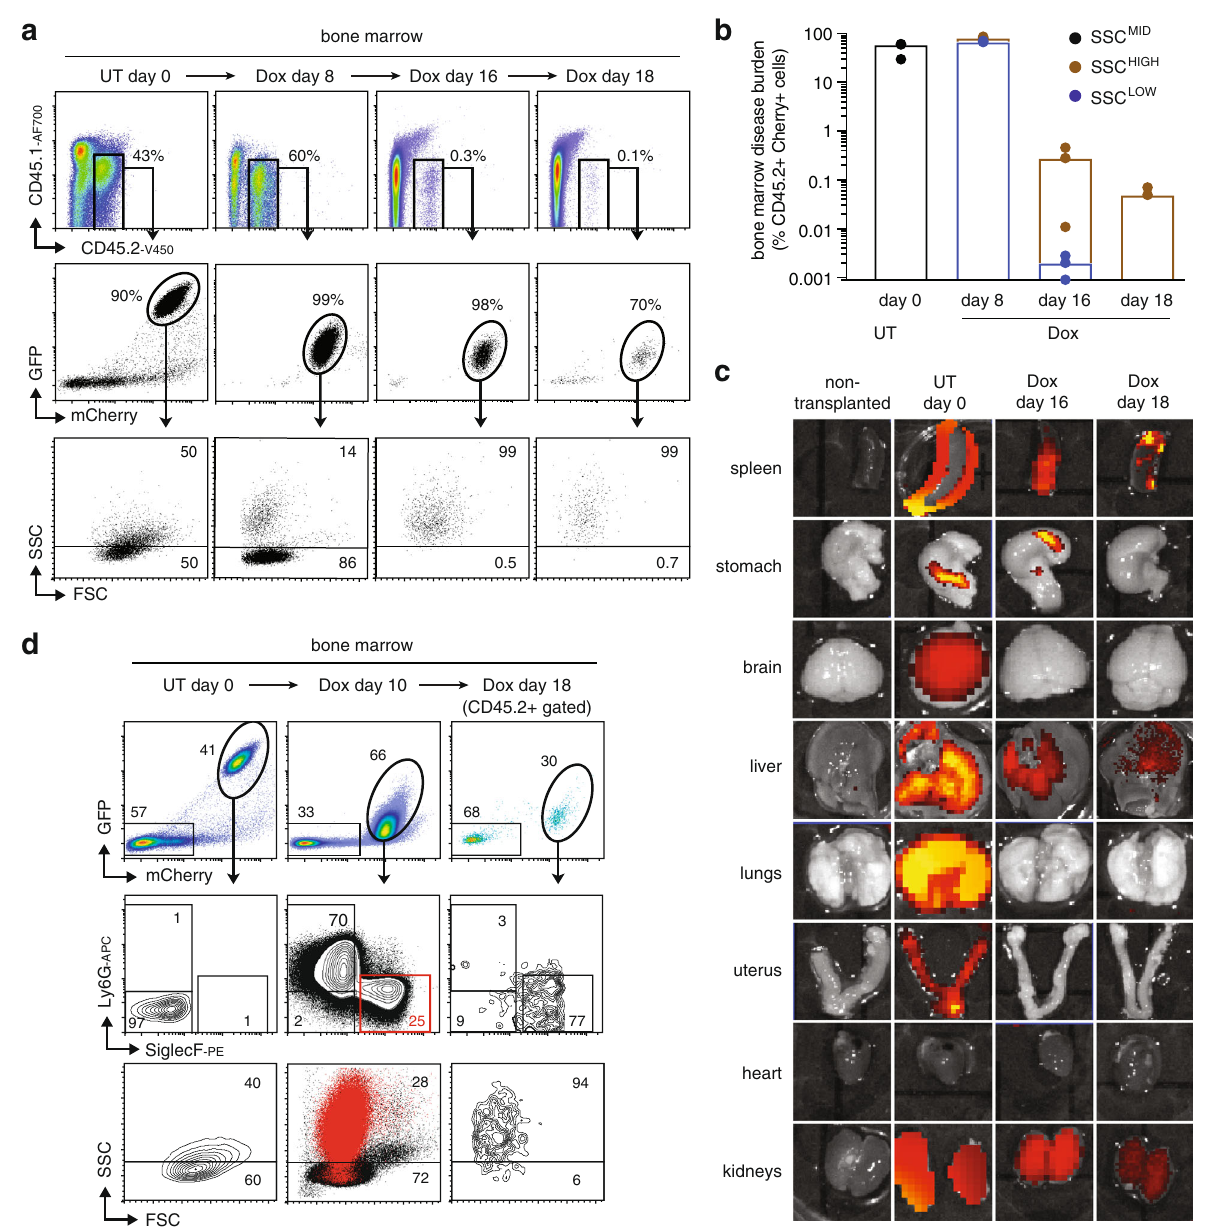
Fig. 3 Persistence of AML-derived SSC HIGH eosinophil-like cells during disease remission. a FSC/SSC pro fi le of AML-derived cells harvested from the bone marrow of representative AML246-Cherry leukemic mice during an 18 day Dox treatment time course, showing viable AML-derived cells identi fi ed based on surface CD45.2 and mCherry. b Abundance and proportion of SSC HIGH and SSC LOW AML-derived cells during the 18 days Dox treatment time course (mean + / − standard error; n = 3 mice for UT day 0, Dox day 8 and 16; n = 2 mice for Dox day 18). c mCherry imaging by IVIS of organs from mice analyzed in a, either untreated or following 16 – 18 days Dox treatment. At each time point leukemic mouse organs were imaged alongside matched control organs from a non-transplanted Rag1 − / − mouse for signal calibration. d Flow cytometry analysis of AML-derived (mCherry + ) cells from representative mice showing leukemia bifurcation into GFP LOW SSC LOW Ly6G + neutrophil-like cells and GFP LOW SSC HIGH SiglecF + eosinophil-like cells at Dox day 10, and relative persistence of AML-derived eosinophil-like cells at Dox day 18. Cells from the red SiglecF + gate in the middle plot are shown in red in the SSC/FSC plot